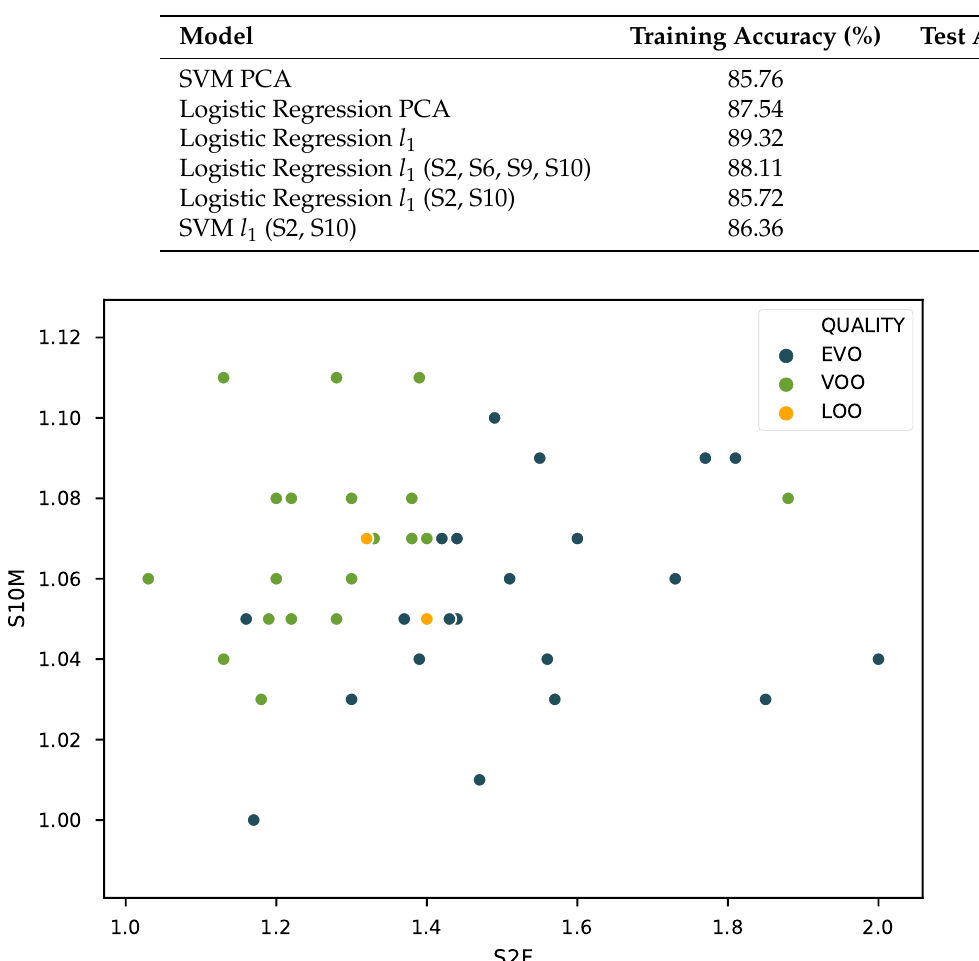
Figure 9. Visualization of the coefficients of the original features for the l 1 logistic regression. Table 3. Results obtained for the detection of defects. The best results are obtained using a logistic regression with l 1 using the features S2M and S10F.